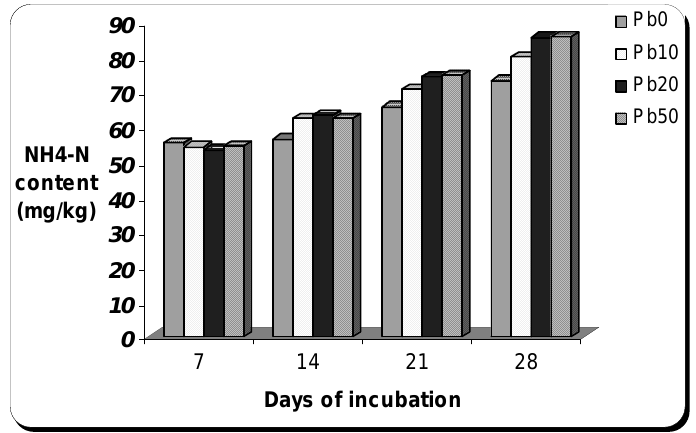
FIGURE 5 . Mean effect of different levels of Pb on the changes in NH 4 -N content under saturated soil.